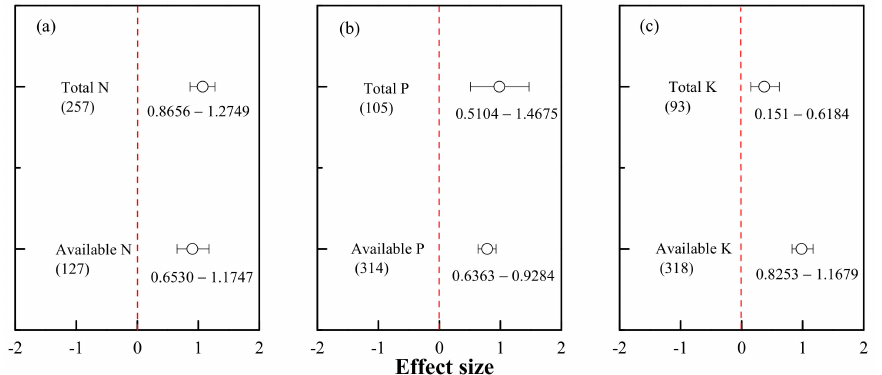
Figure 2. Effects of SDMI application on ( a ) soil total and available N, ( b ) total and available P, ( c ) total and available K, expressed as the mean effect size with bootstrap 95% confidence intervals. The number of observations for each category is given in parentheses. The differences between categories are significant if the probability level ( p ) is <0.05. The overall effect size is significantly positive or negative if 95% confidence interval does not overlap with zero at p = 0.05 level, and the difference in effect size between two categories is significant if 95% confidence intervals in the categories are not